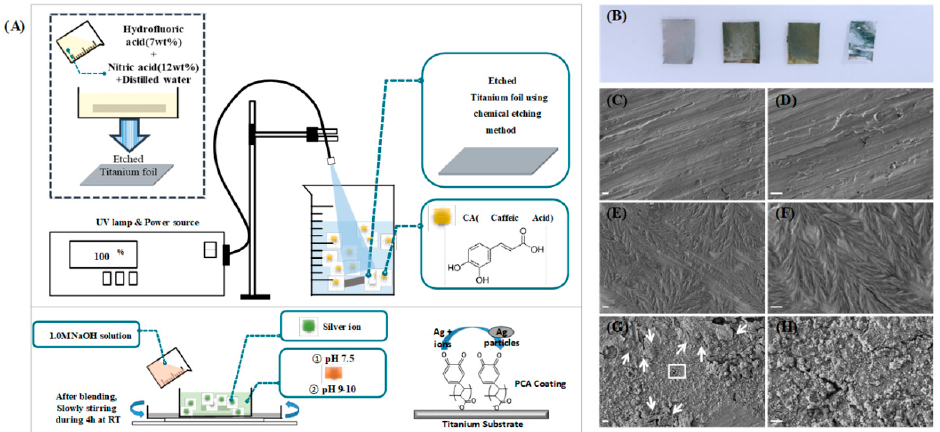
Figure 1. ( A ) Schematics of the process of coating polycaffeic acid (PCA) on etched titanium (upper image) and synthesis of metallic silver on the Ti–PCA substrate (lower image) and ( B ) photo and ( C – H ) FE-SEM image in two magnitudes (scale bar X 5.0 k = 1 μ m, 20.0 k = 5 μ m) of titanium foil according to each process.